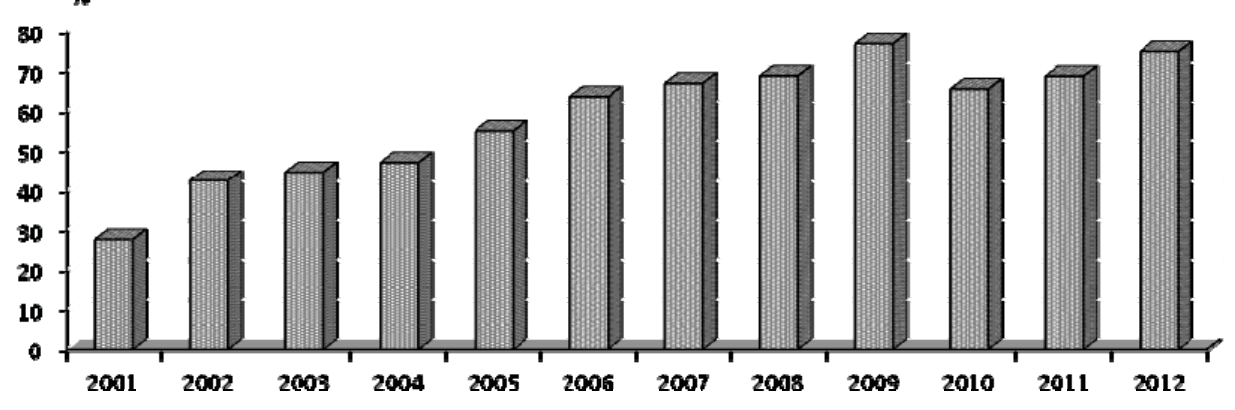
Figure 1. Evolution of the percentage of visited farms using footrests. There were 635 doe farms visited in Spain and Portugal during